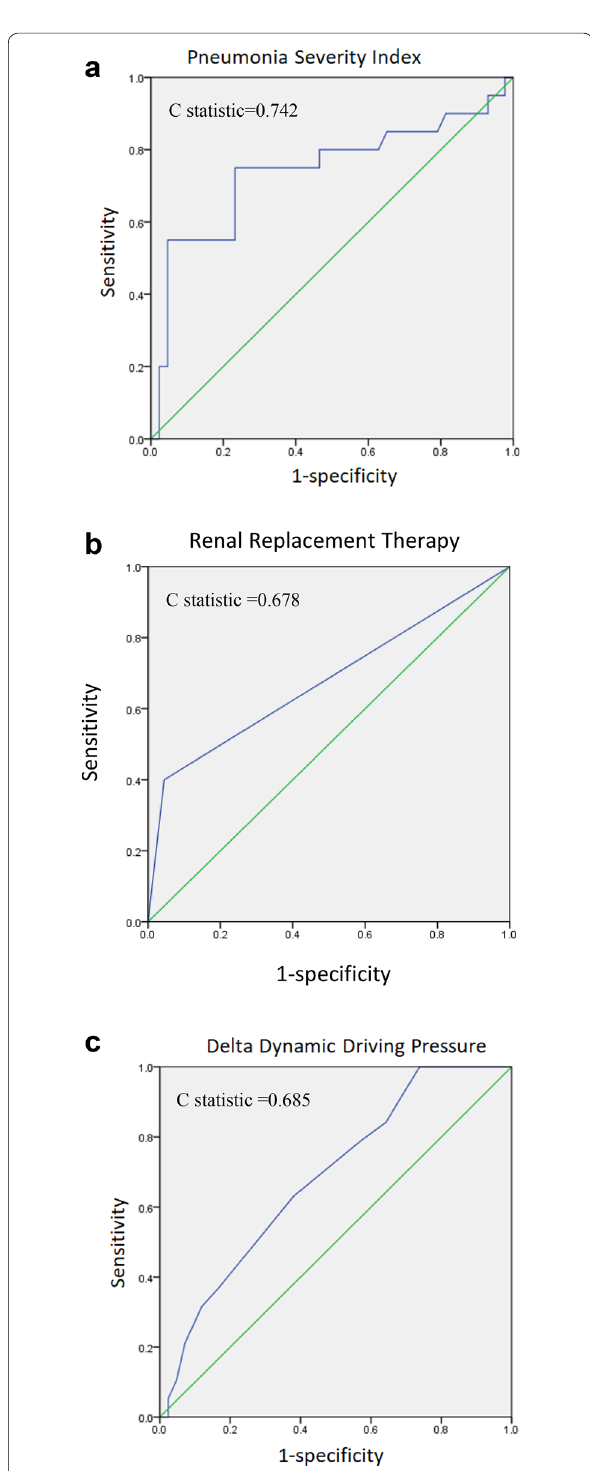
Fig. 2 Receiver operating curves analysis and C statistics of continuous variables of predictors. a pneumonia severity index, b renal replacement therapy and c delta dynamic driving